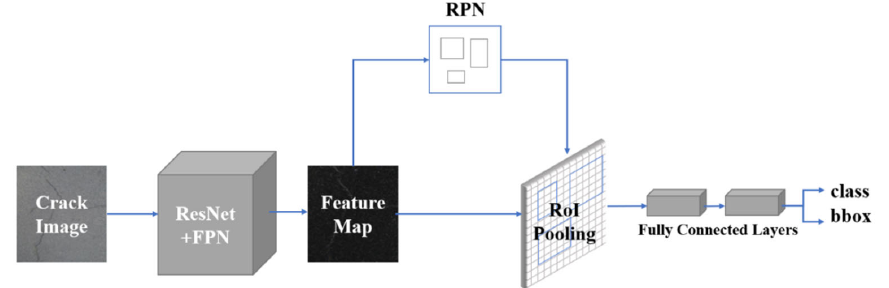
Figure 6. Pipeline of Faster